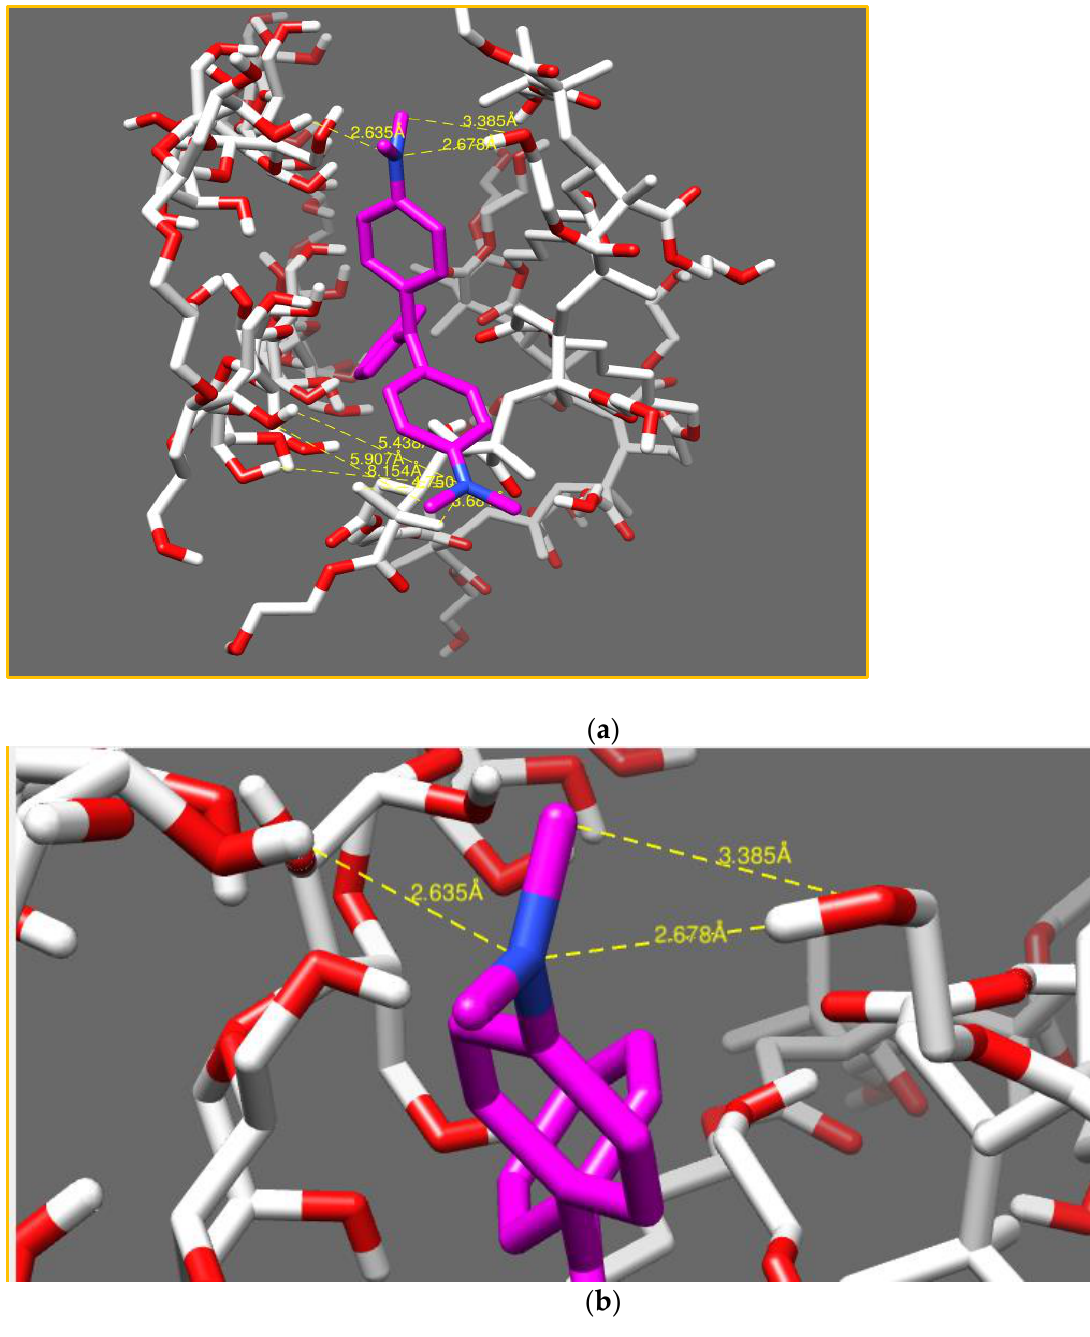
Figure 17. Representation of interactions in the system (cellulose–polyHEMA hydrogels/malachite green-based IPN) ( a ). Aggrandizement of the interactions ( b